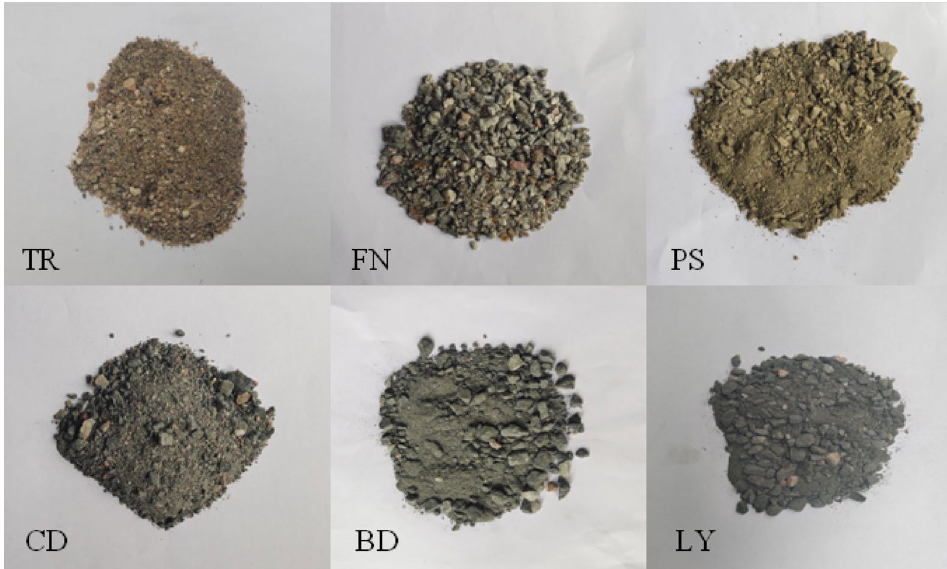
Fig. 1 Natural river sand and iron tailings sand samples